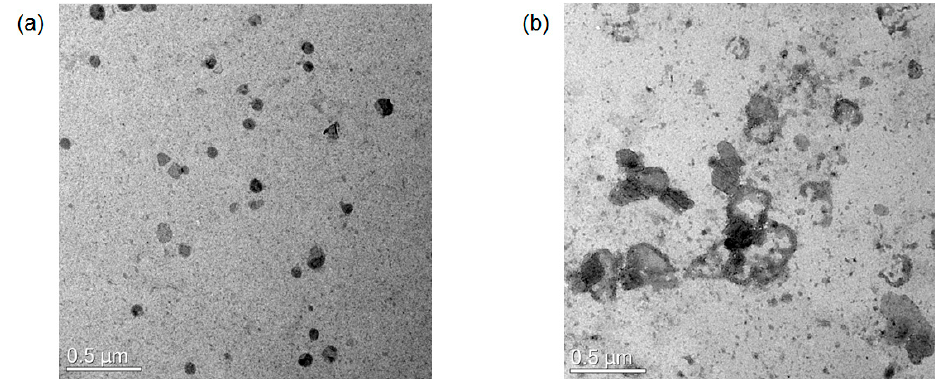
Figure 4. TEM images of the antibody-conjugated PDA nano-vesicles. ( a ) Without virus antigen; ( b ) With virus antigen.